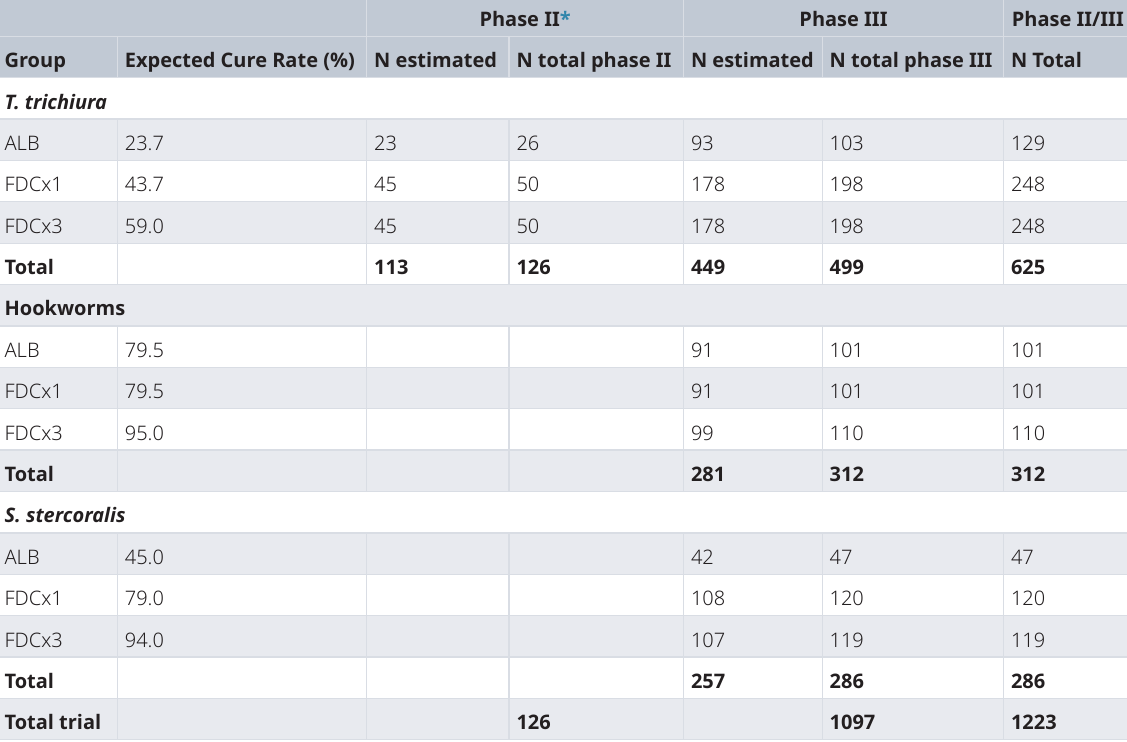
Table 2. Sample size according to the expected efficacy (CR) of the different treatment. The estimated sample size was calculated for pairwise comparisons of the expected CR for three study groups with an overall significance level of 5% adjusted for multiple tests by Bonferroni’s correction, and 80% power. The total sample size was calculated by inflating the estimated calculation by 10% considering losses to